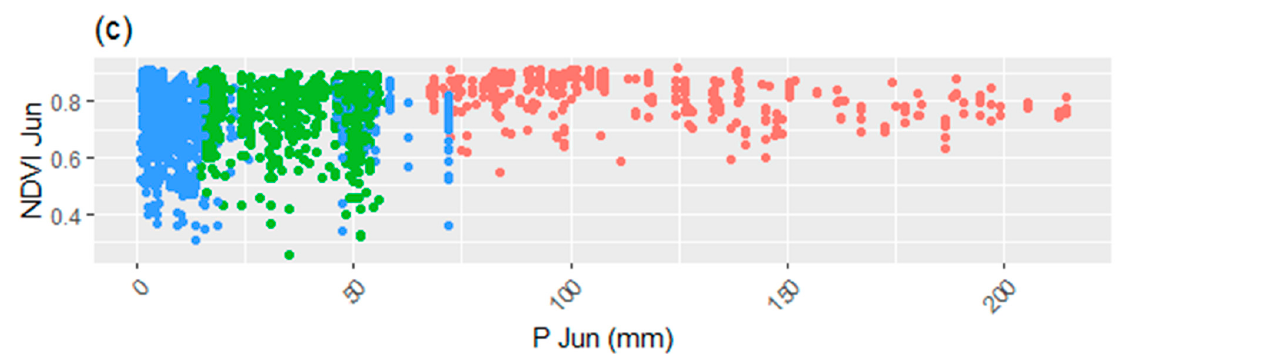
Figure 8. ( a ) Scatterplot of NDVI observation and precipitation for the month of January; ( b ) scatterplot of NDVI observation and precipitation for the month of February; ( c ) scatterplot of NDVI observation and precipitation for the month of June.